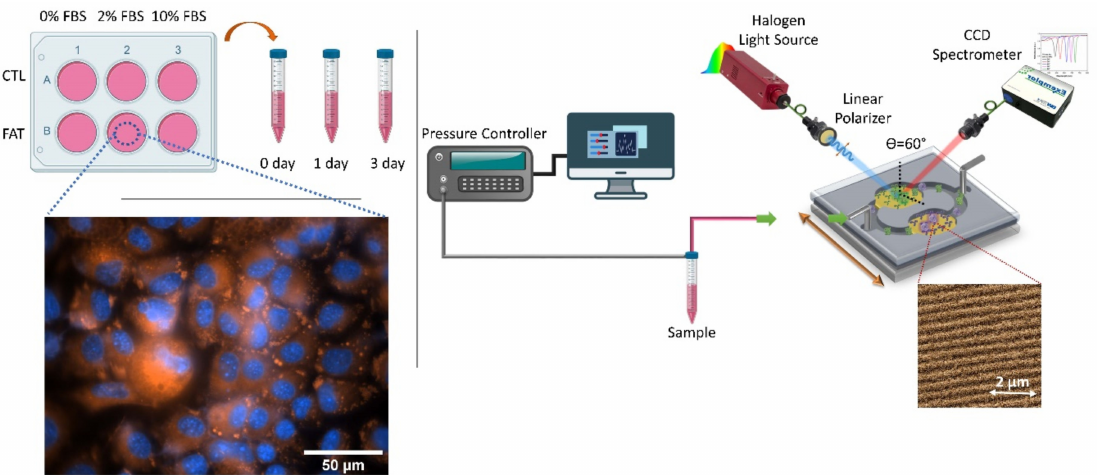
Figure 1. Schematic representation for developing a high throughput plasmonic sensing platform for monitoring albumin levels in 2D in vitro model of fatty liver